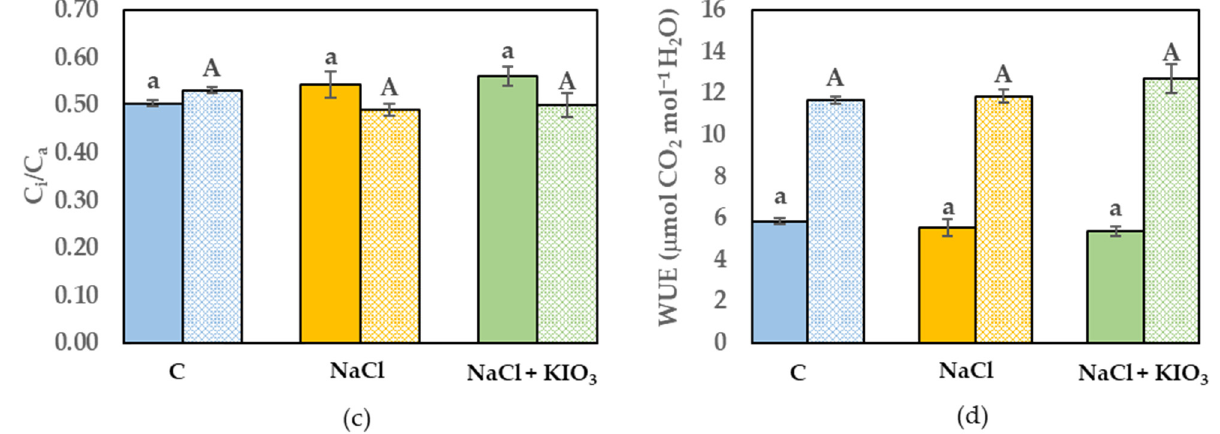
Figure 1. ( a ) Net photosynthesis (A N ); ( b ) stomatal conductance (G s ); ( c ) intercellular to ambient CO 2 concentration ratio (C i /C a ); ( d ) instantaneous water use efficiency (WUE) measured in plants fertilized with nutrient solution (C), in plants fertilized with nutrient solution plus salt (NaCl), and in plants fertilized with nutrient solution plus salt and iodine (NaCl + KIO 3 ). Filled bars: measurements to ambient CO 2 ; cross-linked bars: measurements to elevated CO 2 . Data are means ± SE. Different letters indicate statistical difference among treatments ( p < 0.05).